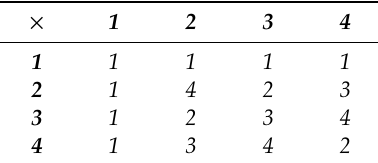
Table 11. The operation × on